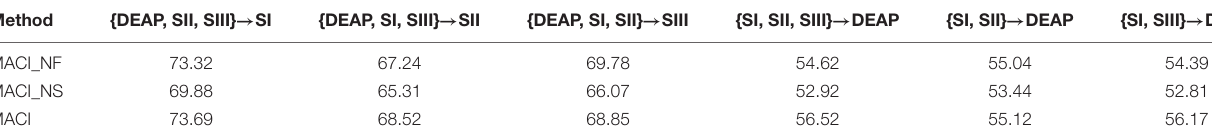
TABLE 4 | Cross-dataset emotion recognition rates with different strategies of parameter settings.